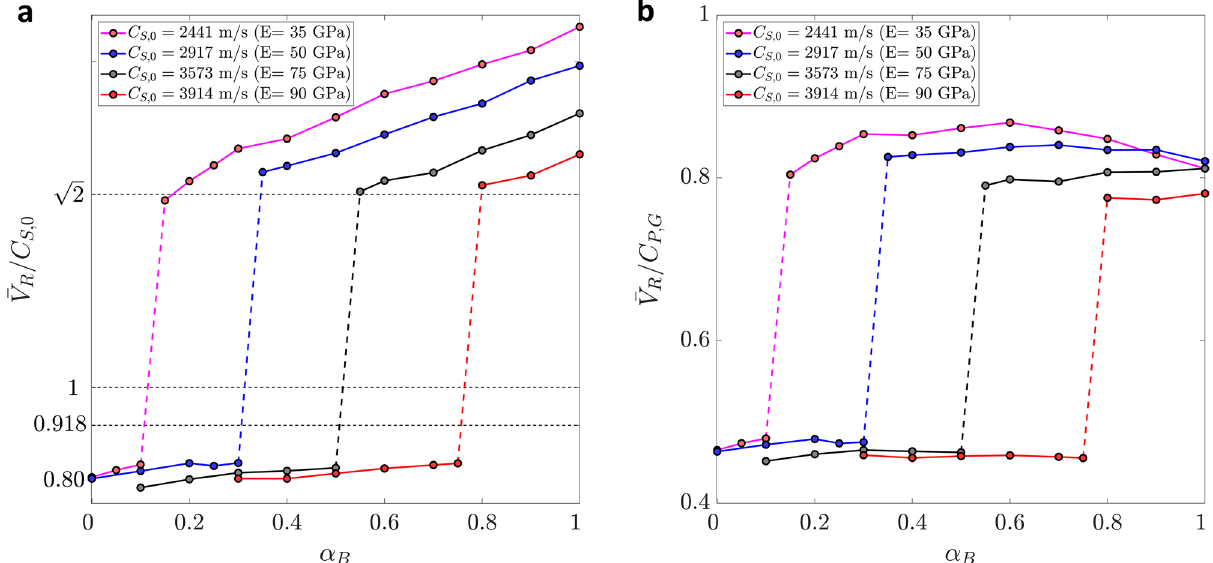
Figure 4. Impact of rock poromechanical properties on rupture speed. ( a ) The transition from sub-Rayleigh to supershear ruptures occurs at larger values of the Biot coefficient as the material becomes stiffer. The normalized rupture speed, V R / C S ,0 indicates that ruptures tend to be sub-Rayleigh when poroelastic coupling is weak (smaller α B ), while strong coupling (larger α B ) favours supershear ones. For given confinement stresses, rock 0.8 C stiffness controls the transition from sub-Rayleigh, with ¯ V R S , to supershear beyond the Eshelby speed, ¯ V R ≈ √ 2 C S ,0 . ( b ) Using the same results as in ( a ), we normalize rupture speeds using the Gasmann modification ≥ of the compressional wave speed, C P , G . Ruptures stabilize around a normalized speed of 0.8. The confinement conditions are (σ x , σ y ) (130 MPa, 50 =